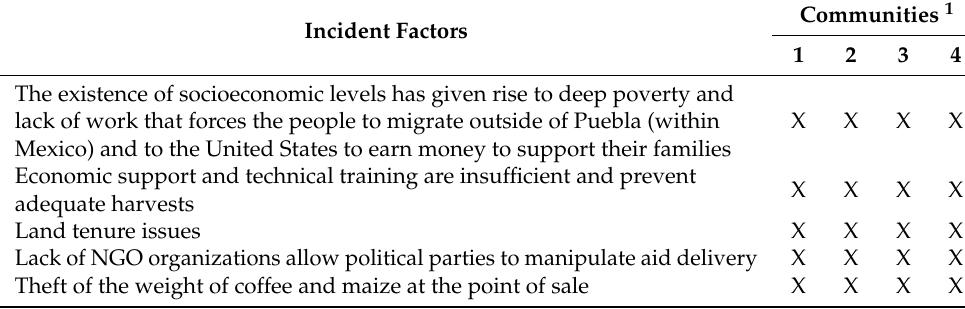
Table 1. Factors affecting social capital in the study communities. Incident Factors Patron saint festivals of the Catholic religion and construction of altars on X X X X the day of the faithful (sharing of food) Cronyism, kinship networks across marriage links X X Christmas parties and festivities during the year (sharing food) – – Collective aid and altruistic financial cooperation in the event of the death to X – one member inside the community and mutual support Moral presence of the Priest and practice of customary to get justice and peace